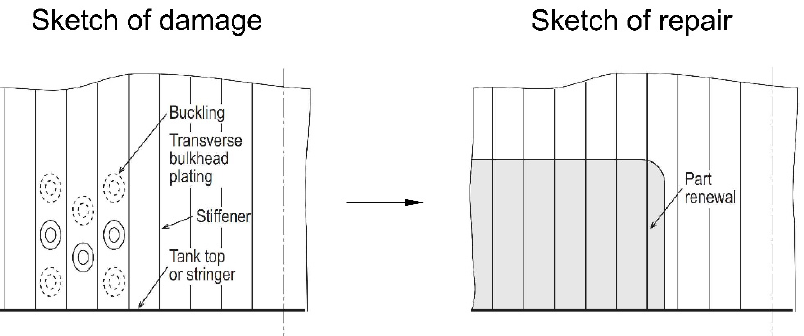
Figure 1. IACS [1] recommended repair practice for buckling caused to a part of a transverse bulkhead (in cargo hold region) possibly caused by heavy general corrosion.